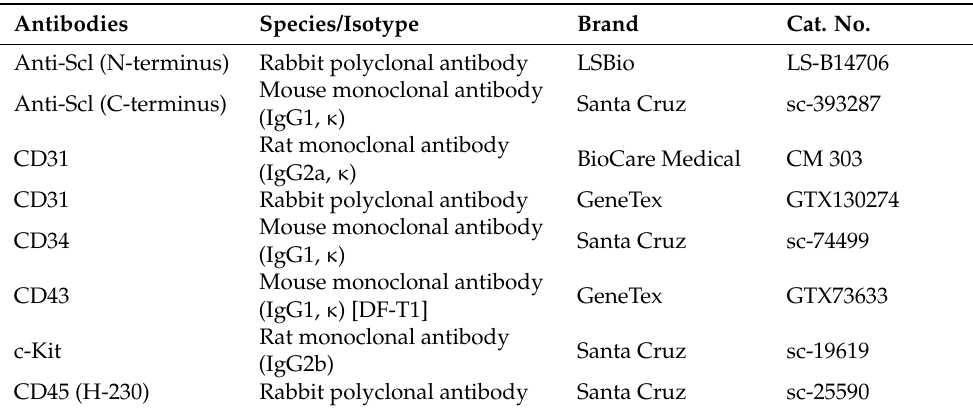
Table 2. Primary antibodies used in this